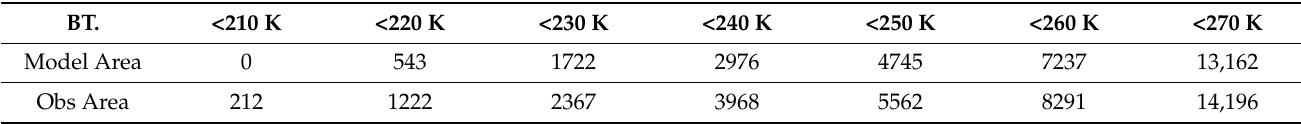
Figure 2. ( a ) observed and ( b ) model synthetic GOES-R IR BT (in K) fields of the mature stage of hurricane Dorian from 30 August 18Z to 6 September 18Z of 2019. The white markers are the radii of the 34 kt (triangles), 50 kt (+signs) and 64 kt (circles) winds from best track in ( a ) and the model forecast track in ( b ). The red crosses indicate the location of minimum observed BT of 206 K and minimum model synthetic BT of 211 K. Table 1. The number of pixels whose BT are below the